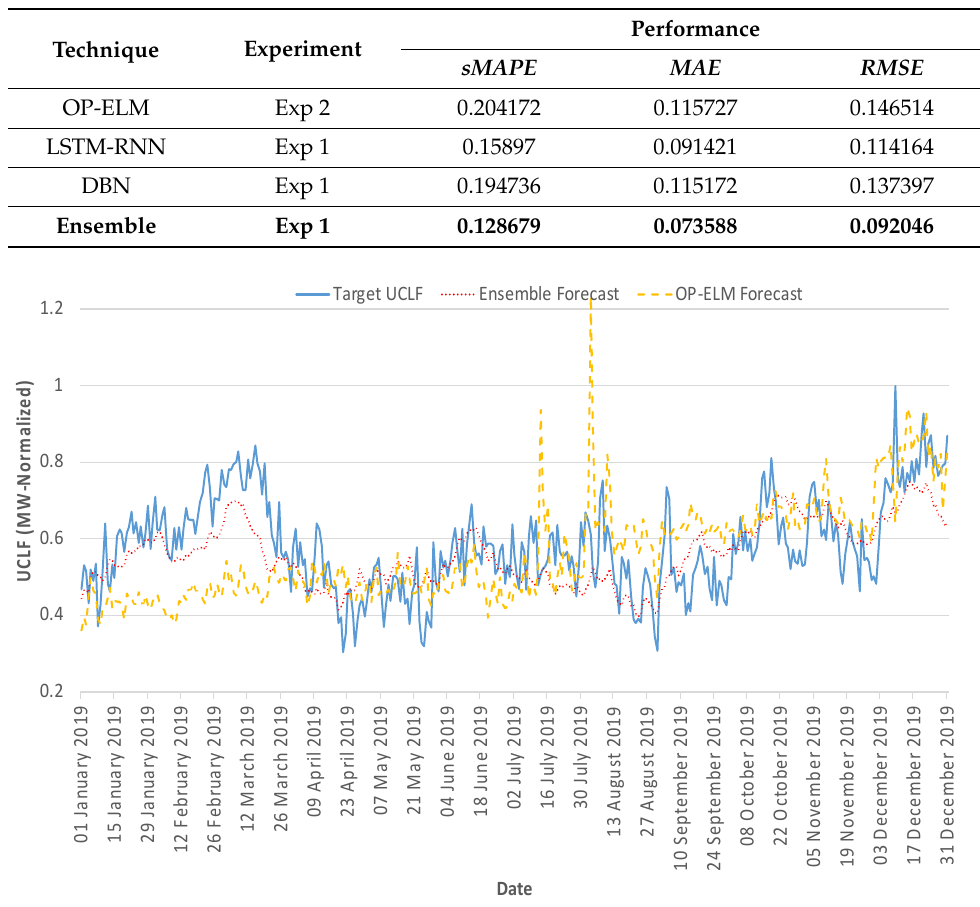
Table 9. Summary of lowest obtained errors per used technique.